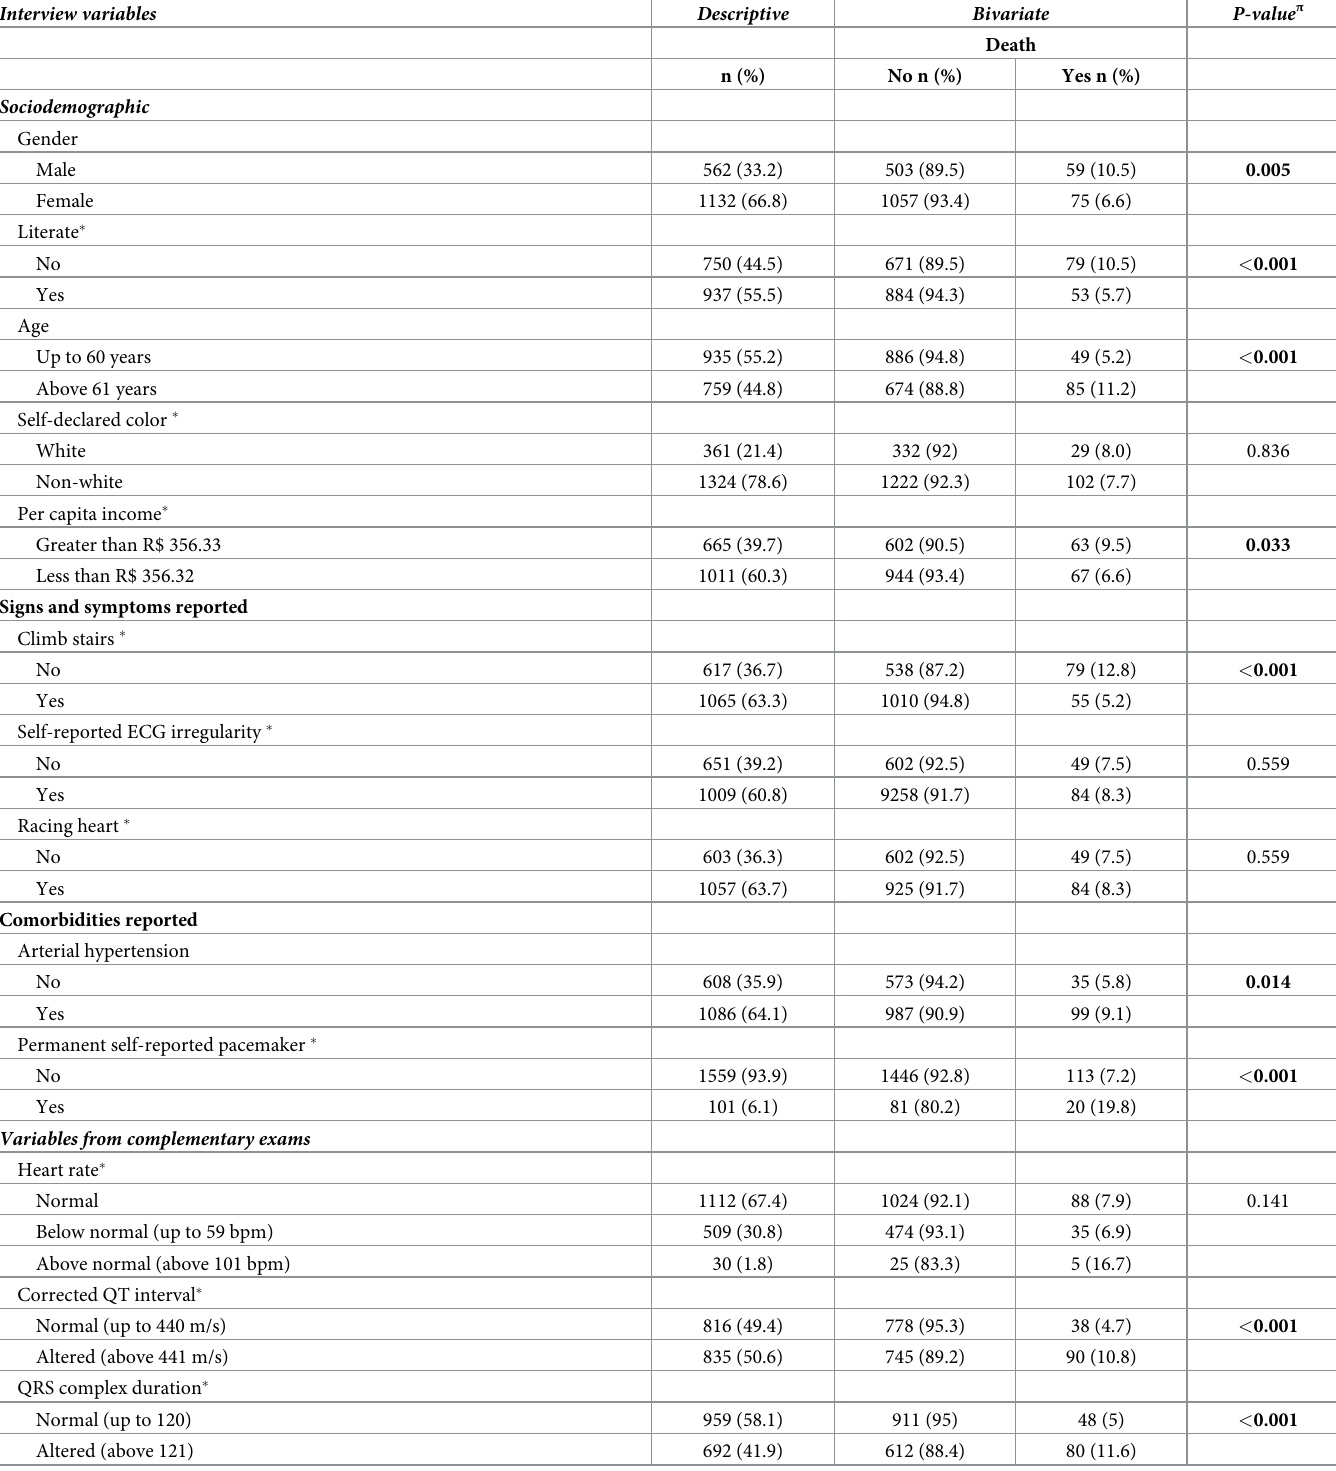
Table 2. Descriptive and bivariate analysis of categorical predictor variables selected among those with the greatest predictive power, and their association with death in patients with Chagas disease (CD). Minas Gerais, Brazil (n =